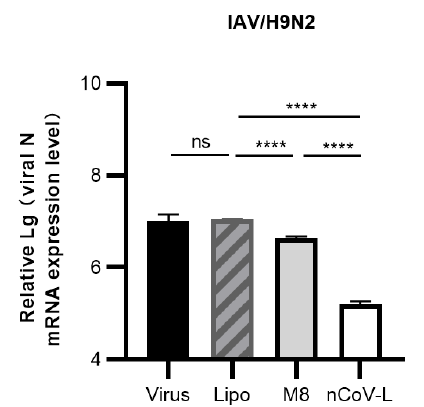
Figure A3. The in vitro antiviral effect of nCoV-L against IAV/H9N2. 2 × 10 5 A549 cells were transfected with 1 ng/mL nCoV-L or M8 for 24 h and then infected with IAV/H9N2 (1 MOI) for 24 h. Cells were harvested, and total RNA was extracted. Viral loads were measured by RT-qPCR. Viral loads are shown. N=3, bar indicates SD. ns, p > 0.05, ****, p < 0.005.